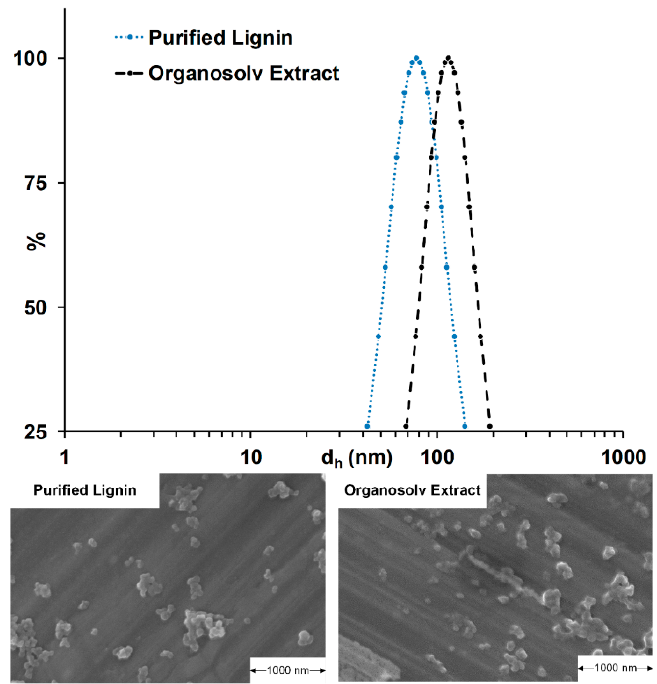
Figure 3. Hydrodynamic diameter distributions and SEM images of lignin particles precipitated directly from organosolv extract and from purified lignin (PL) solutions. Precipitation parameters used were pH 7, antisolvent/exctract ratio of 5 and a flowrate of 112.5 mL/min in the static mixer.